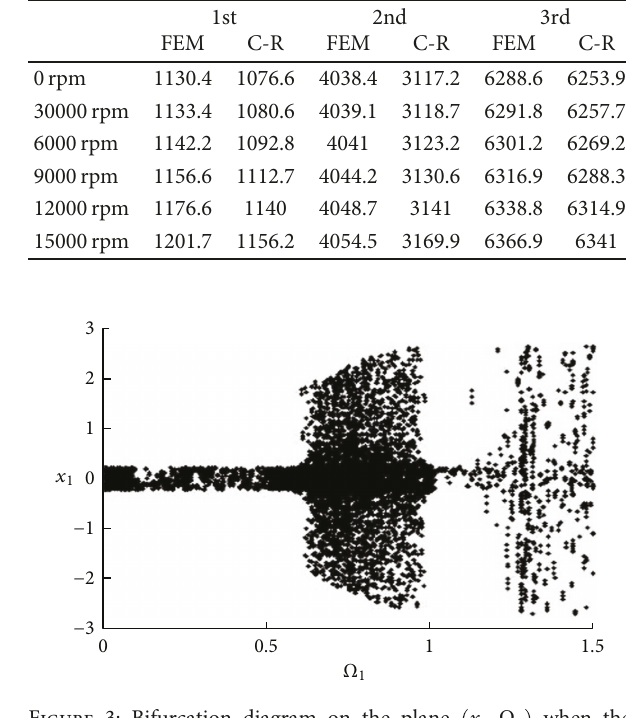
, Ω when the 1 1 varies in the interval Ω = 0~1 5 . 1 1 = 0 2 , x = 0 101 , x = − 0 26 , and 10 20 30